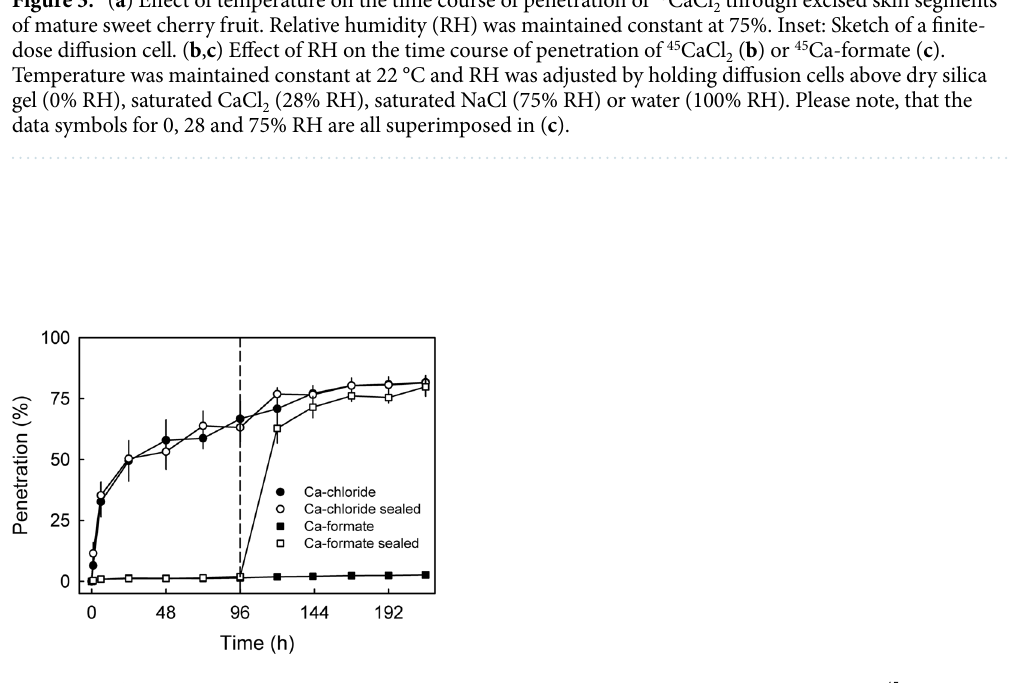
Figure 4. The effect of increasing the relative humidity (RH) (from 50 to 100%) on penetration of 45 CaCl 2 and 45 Ca-formate through excised skin segments of mature sweet cherry fruit at 96 h after droplet application. Penetration was monitored at 22 °C and 50%